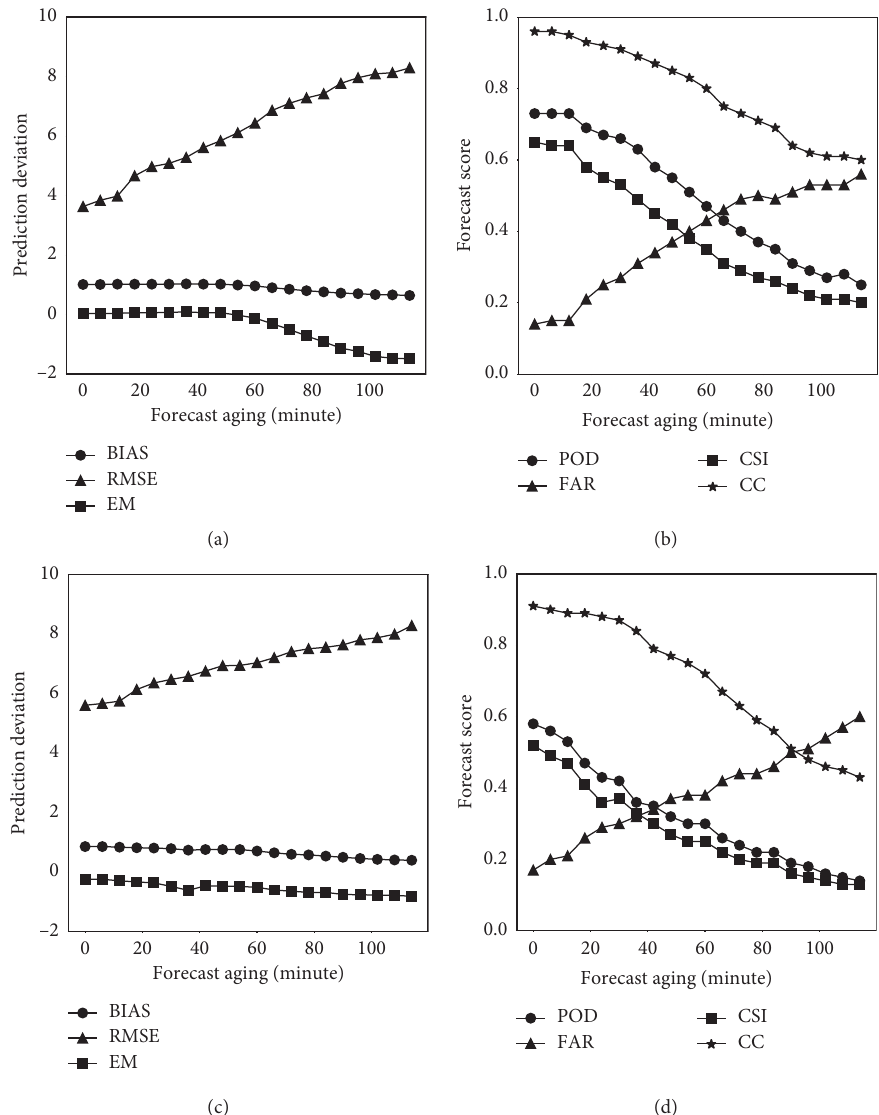
Figure 3: Forecast bias and forecast score for 2 hours starting at 1100UTC July 14 2017: (a, b) the results of the ConvLSTM method; (c, d) the results of the optical flow